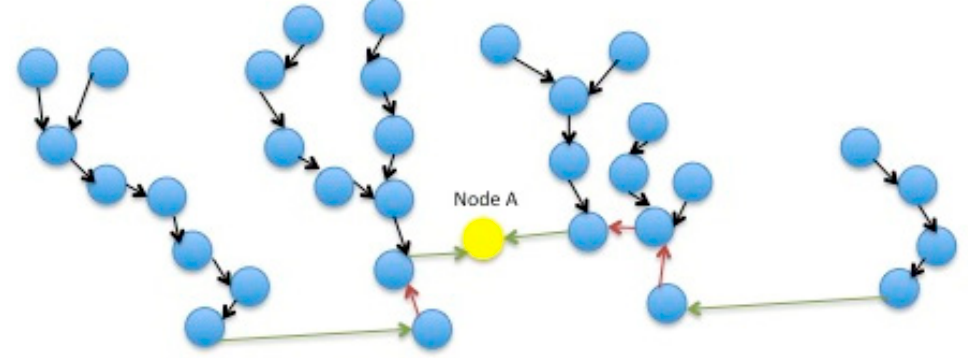
Figure 4. Phase 2: network in its infancy. Non-affected links (black arrows). Reversal of the direction of information flow (red arrows). Creation of new links both between motes and between a mote and the node (green arrows).